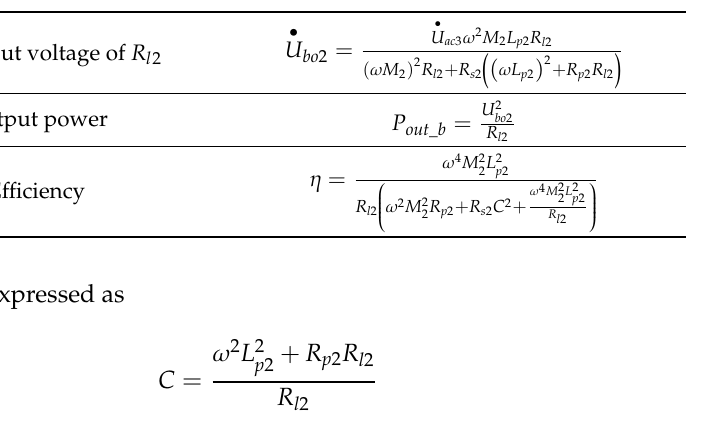
Figure 3. Mode B. Figure 3. Mode B. Table 2. Reverse Table 2. Reverse transmission.